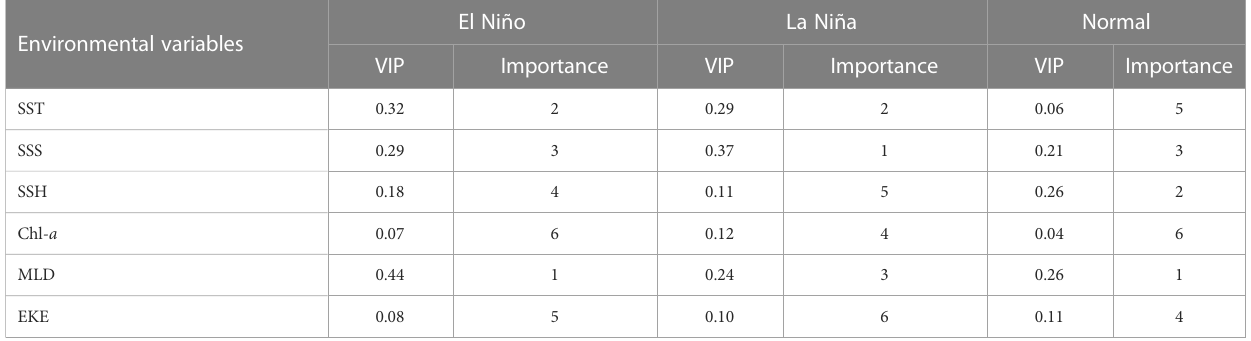
TABLE 1 Proportional weighting of the sea surface temperature (SST), sea surface salinity (SSS), sea surface height (SSH), sea surface chlorophyll- a (Chl- a ), mixed layer depth (MLD), and eddy kinetic energy (EKE) in El Niño, La Niña, and normal years based on VIP scores.